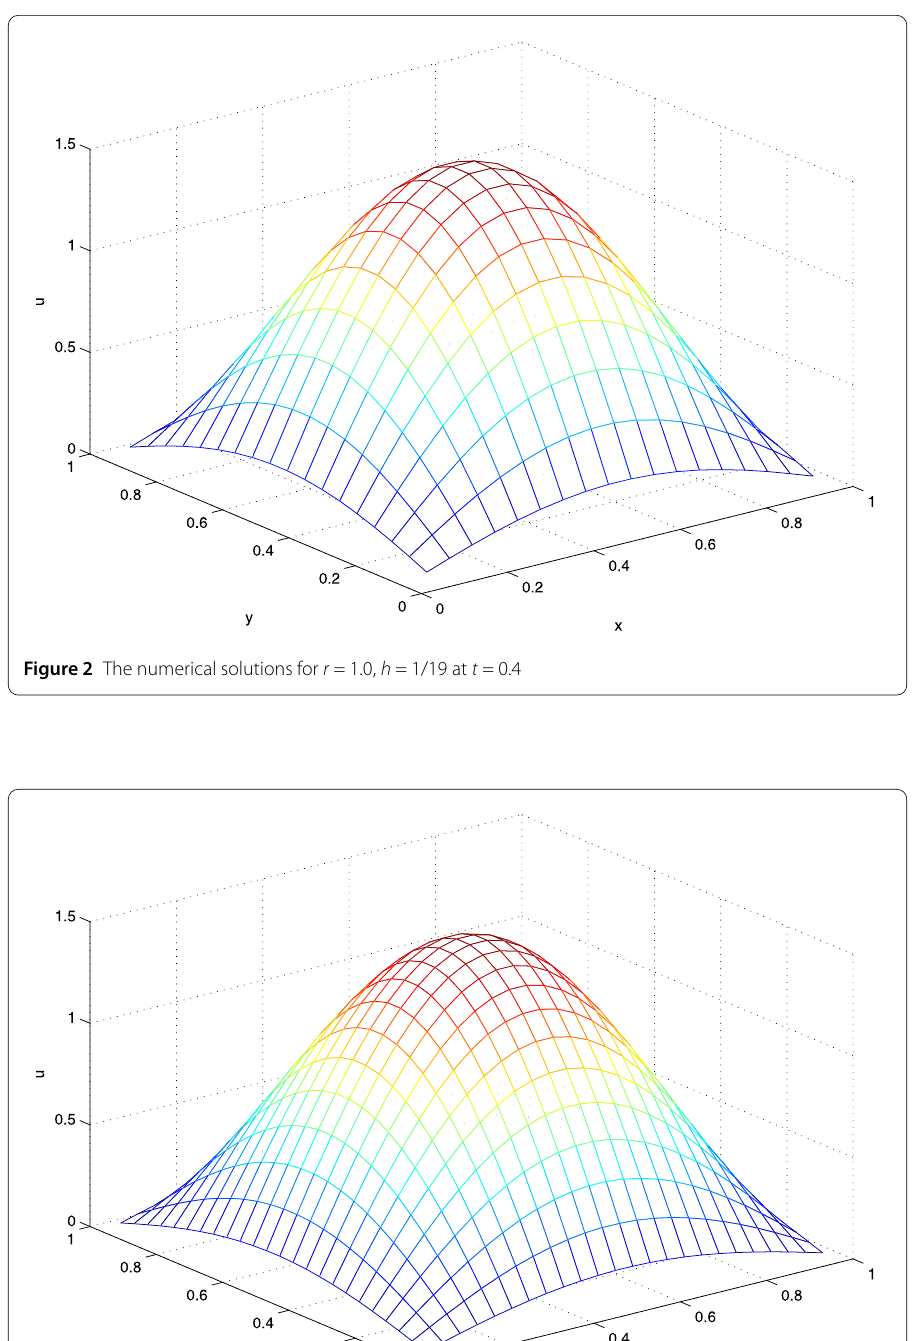
dimensional parabolic equations can be solved by the proposed algorithm in this paper. Numerical experiments illustrate the good performance of the new